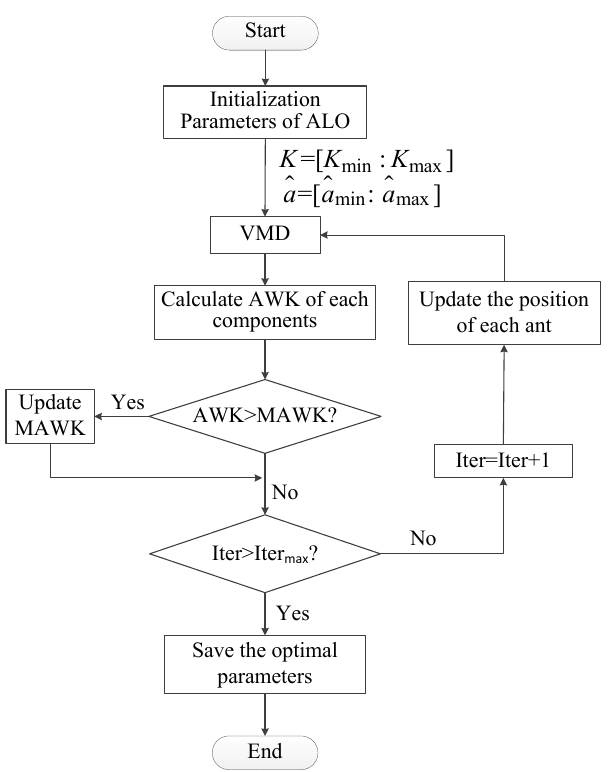
Figure 17. The flow chart of the proposed ant lion optimization-variational mode decomposition (ALO-VMD) method.